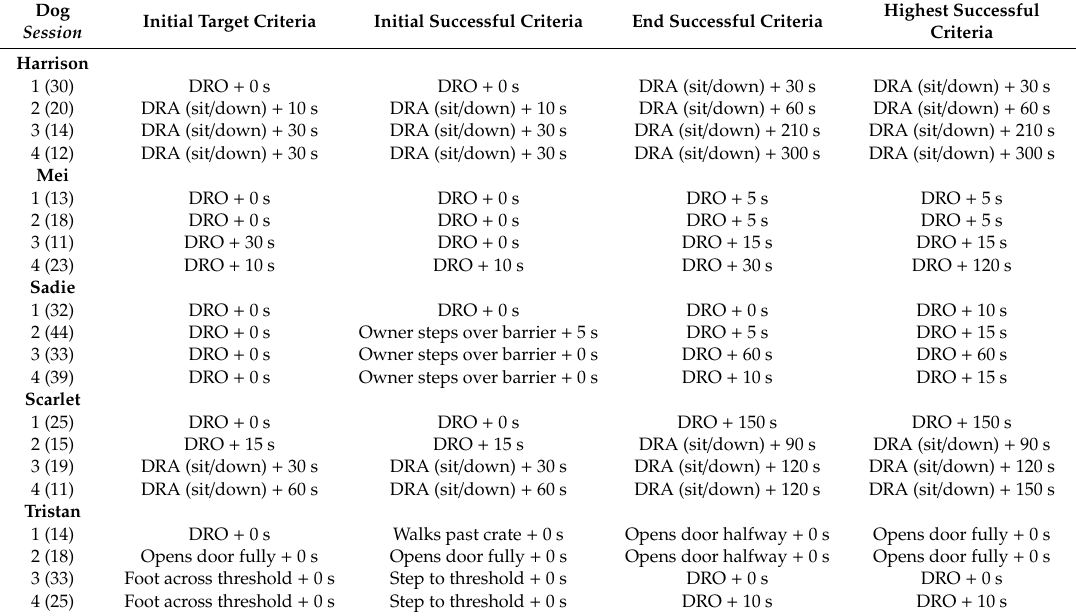
Table 6. Criteria changes for dogs across sessions. The sessions (1–4) for each dog are shown. The number of trials in that session is given in (). Initial Target Criteria reflect the treatment goal for Trial 1 of that session. Initial Successful Criteria reflect the criteria in place when the dog had its first successful trial in that session (no PB). End Successful Criteria reflect the last criteria in place when the dog has its last successful trial in that session. Highest Successful Criteria reflect the highest criteria in place during that session in which the dog had a successful